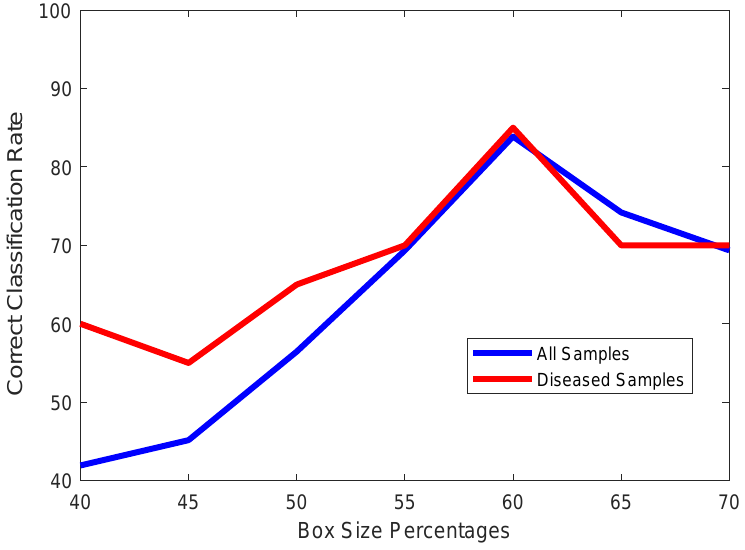
Figure 7. Plot of classification accuracies of all samples (blue) and only diseased samples (red) vs. Percentage of box size regarding the entire